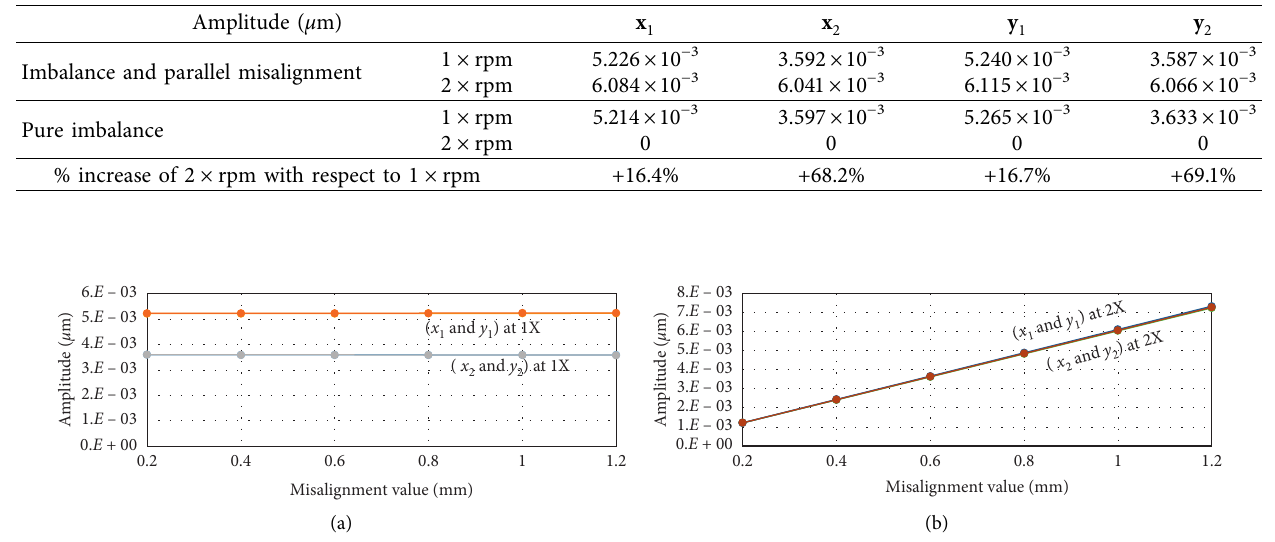
Table 7: Peak amplitudes of the fundamental and second harmonics in the radial direction.